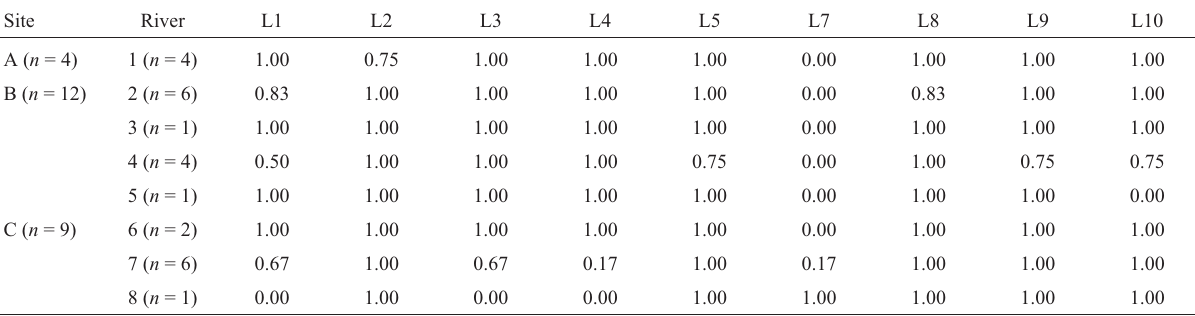
Table I - Band frequencies (locus: L) among nine oligonucleotide primers for H. maximiliani sampled from eight rivers and streams which formed the three sites (A, B, and C) of a drainage in the Parque Estadual de Carlos Botelho. The values indicate the presence frequency of variable bands ( n = sample size).